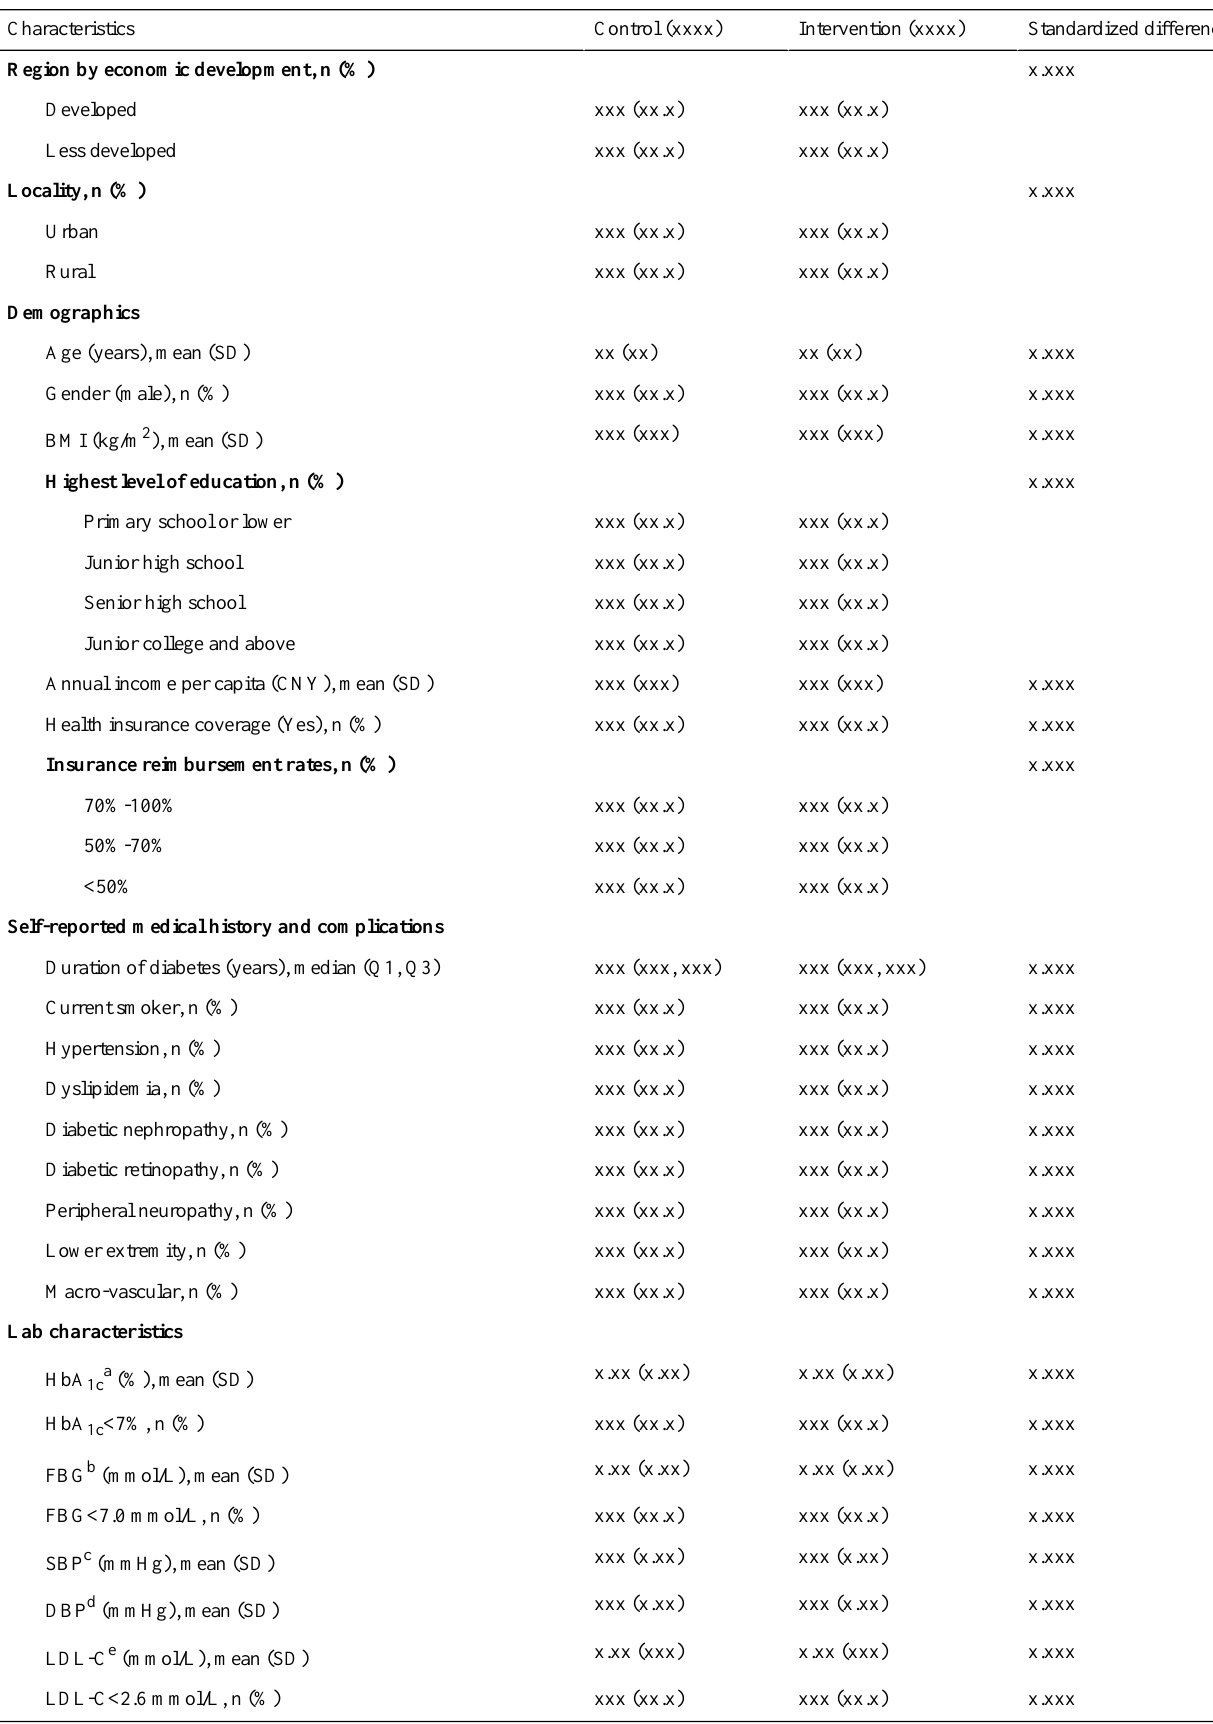
Table 1. Baseline characteristics of participants by treatment arms in the road to hierarchical diabetes management at primary care